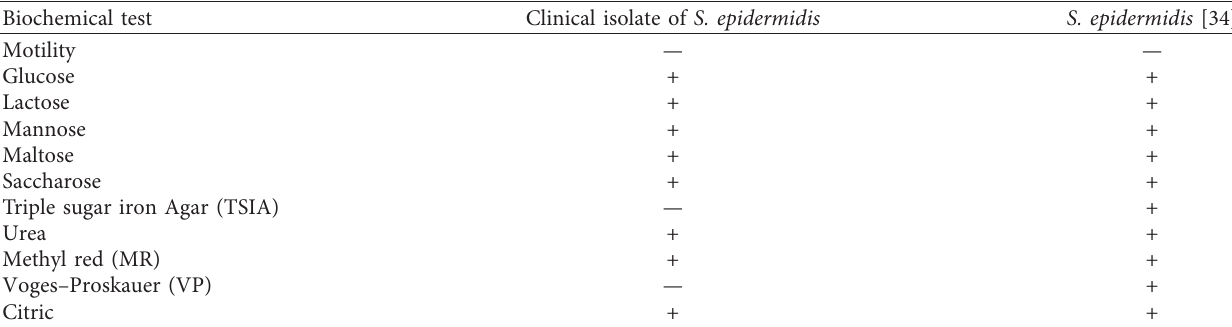
Table 3: Biochemical test results of clinical isolates of S. epidermidis .